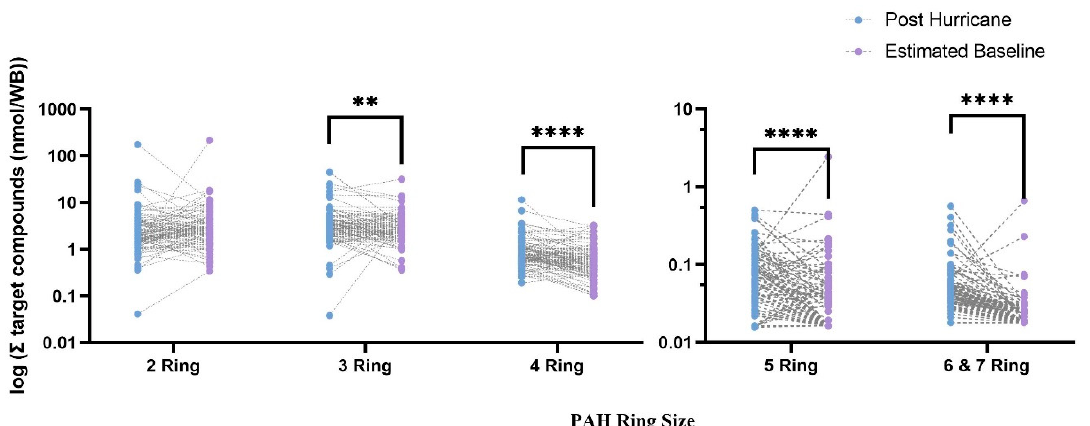
Figure 4. Log scale of sum concentration of PAHs across ring sizes in matched pairs across timepoints. Comparisons represent results from Wilcoxon matched-pair signed-rank tests ** ( p < 0.01), **** ( p < 0.0001).